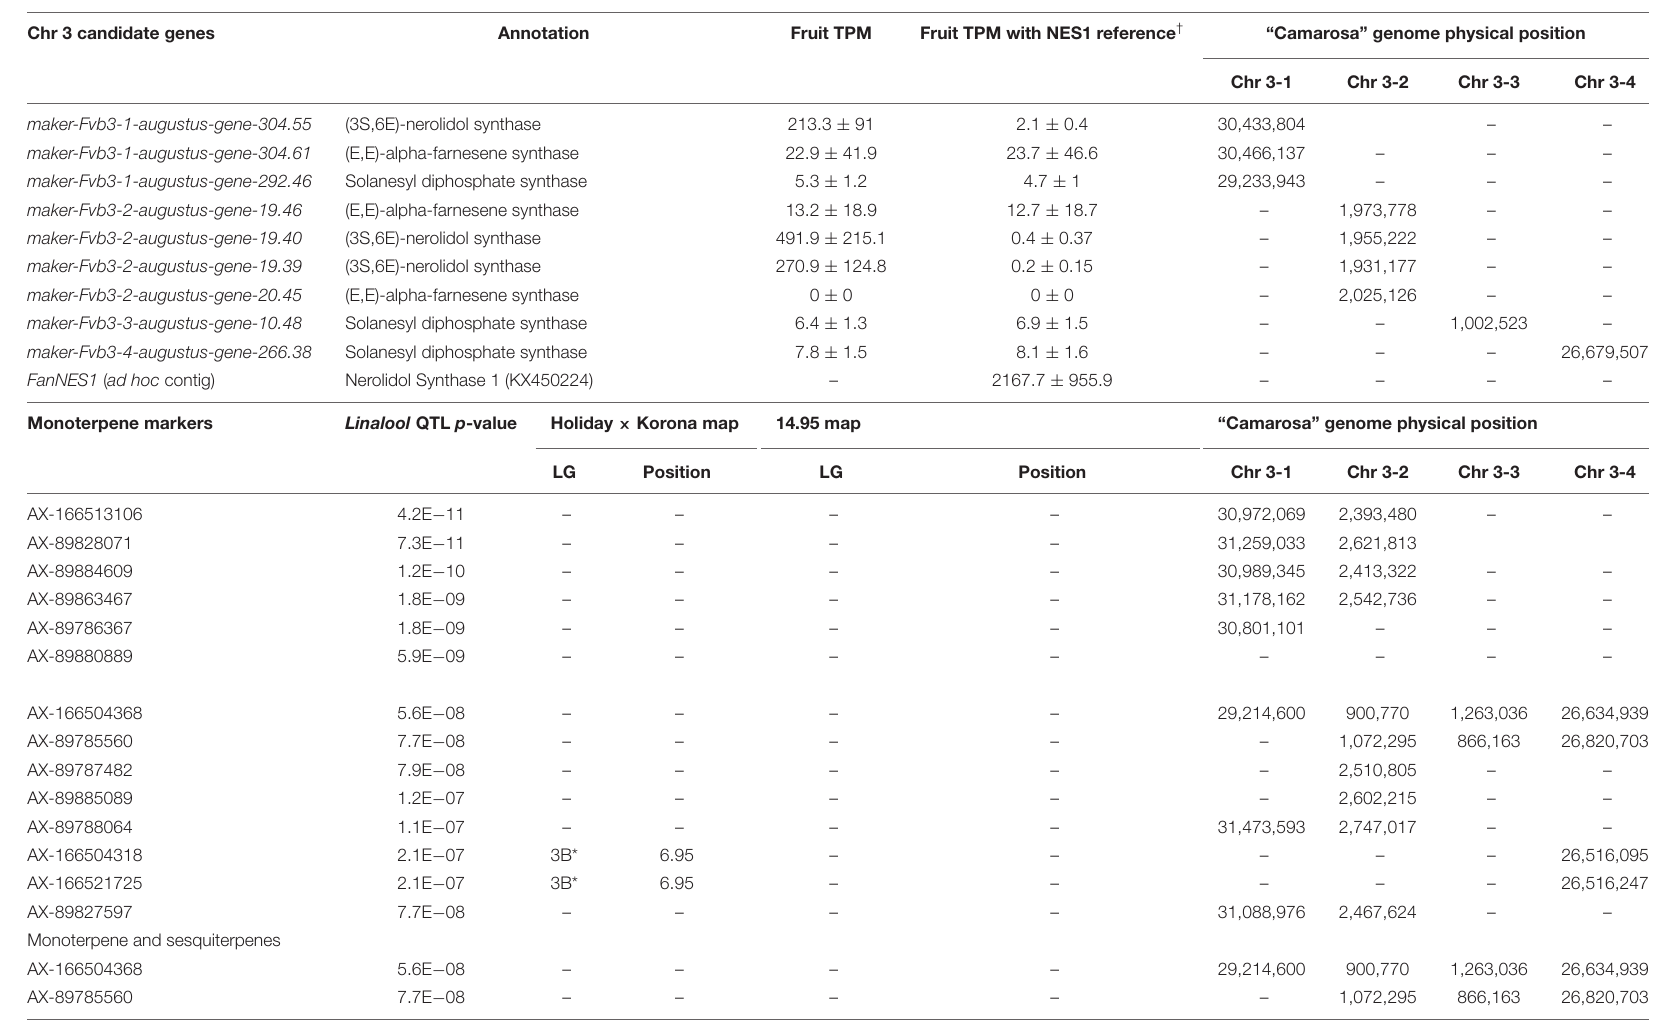
TABLE 3 | Terpene QTL and candidate gene